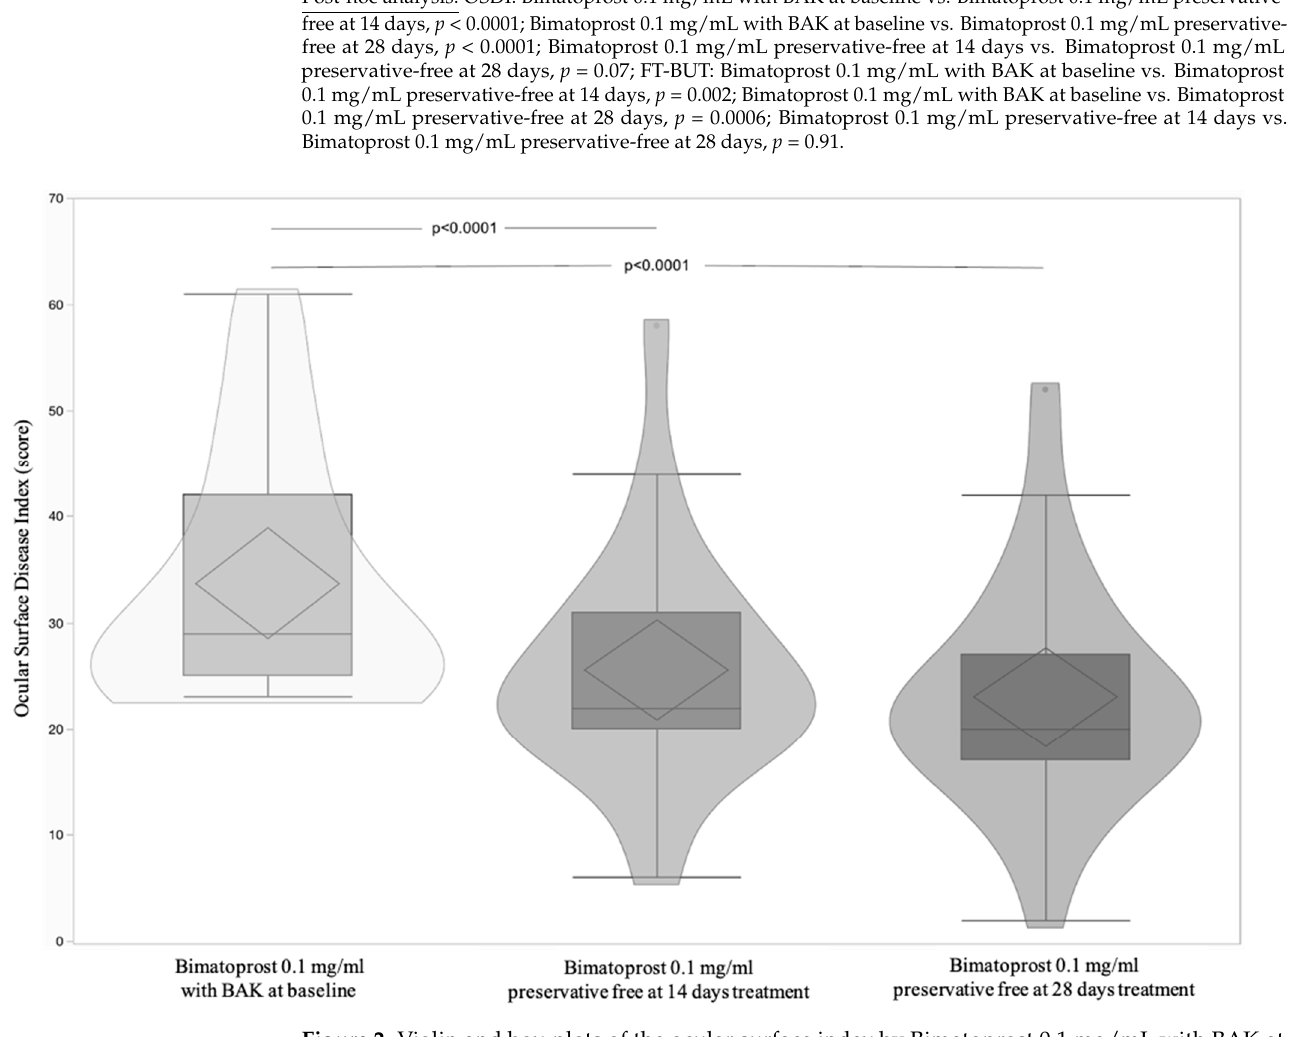
Figure 2. Violin and box-plots of the ocular surface index by Bimatoprost 0.1 mg/mL with BAK at baseline and the Bimatoprost 0.1 mg/mL preservative-free at 14 and 28 days.